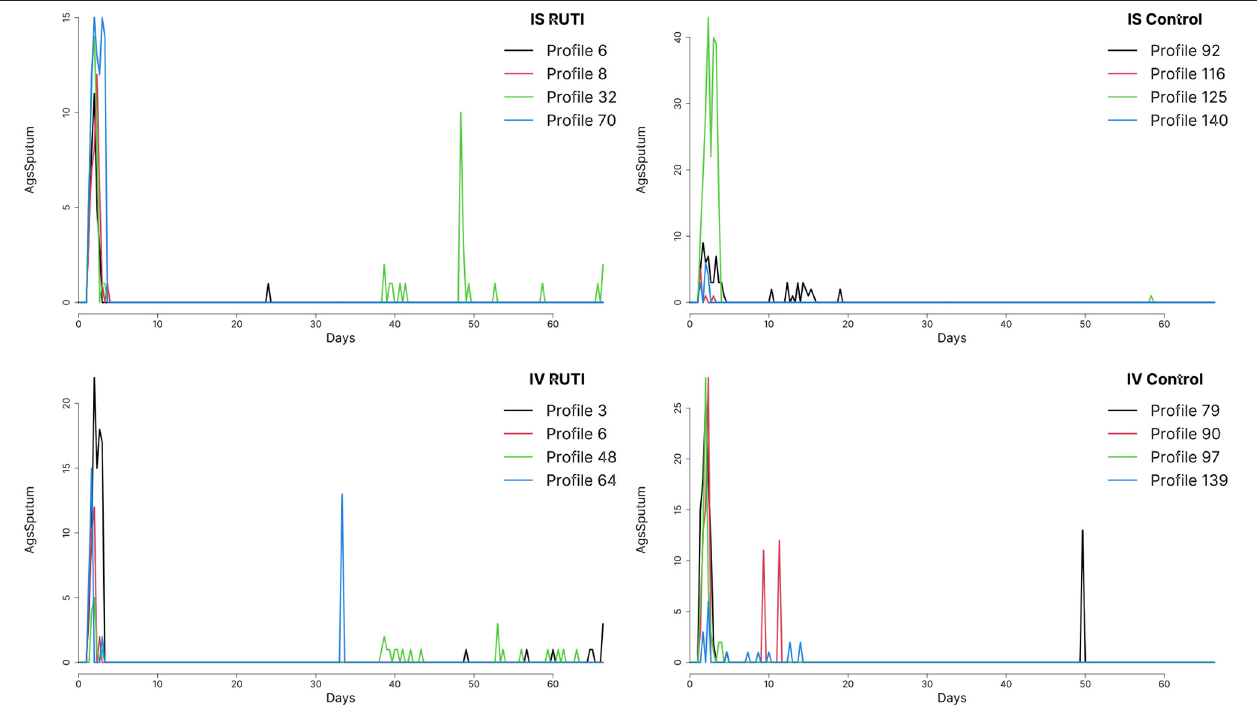
FIGURE 2 | Sputum levels in time from profiles chosen at random from both RUTI and Control groups in the in vivo (IV) and in silico (IS) cohorts, using run 49 out of a 100 available.